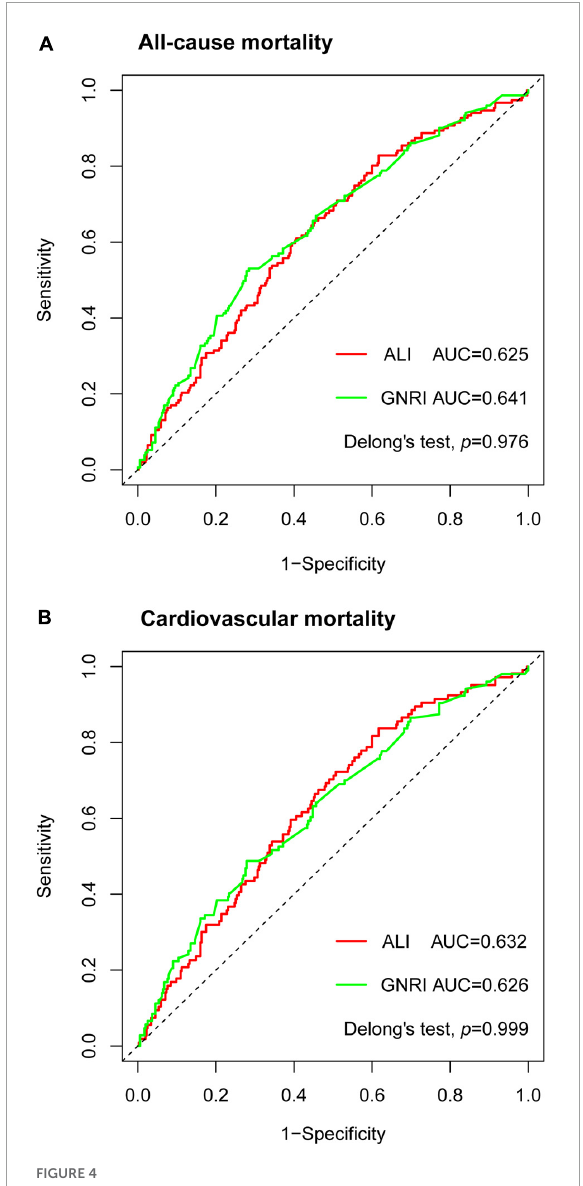
FIGURE4 Time-dependent receiver operating characteristic (ROC) curves of advanced lung cancer inflammation index (ALI) and geriatric nutritional risk index (GNRI) with reference line for all-cause mortality (A) and cardiovascular mortality (B) at 2 years. AUC, area under the curve.